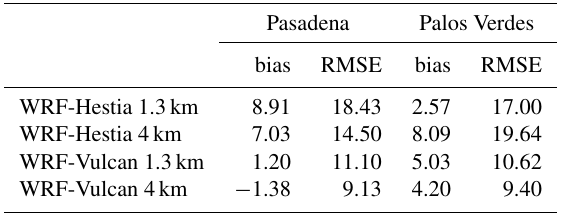
Table 5. Statistics of daily afternoon averaged modelled CO 2 (unit: ppm) with different configurations relative to in situ CO 2 ∗ . Pasadena bias RMSE bias